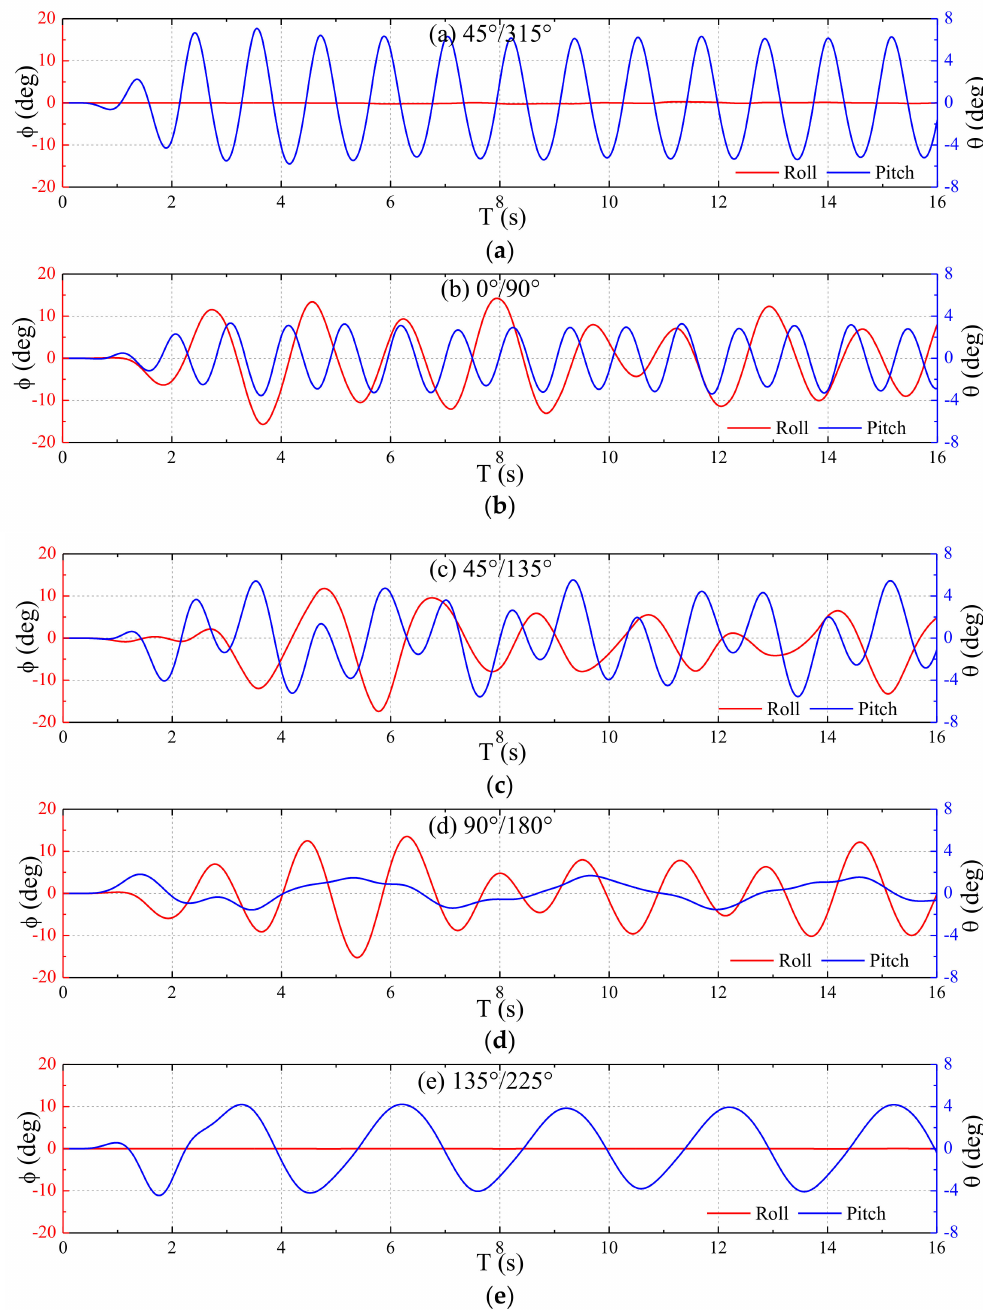
Figure 17. Time series of ship roll and pitch motions in di ff erent wave headings: ( a ) 45 ◦ / 315 ◦ (Case 4); ( b ) 0 ◦ / 90 ◦ (Case 9); ( c ) 45 ◦ / 135 ◦ (Case 10); ( d ) 90 ◦ / 180 ◦ (Case 11); ( e ) 135 ◦ / 225 ◦ (Case